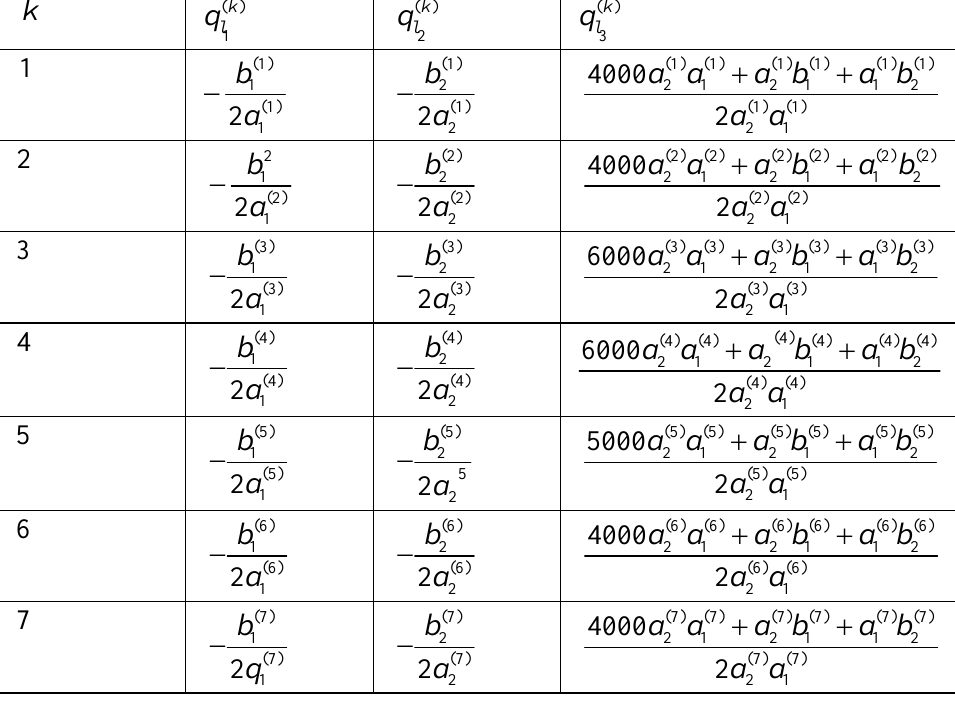
Table 3. Optimal link flows: Total toll revenue maximization with linear toll functions